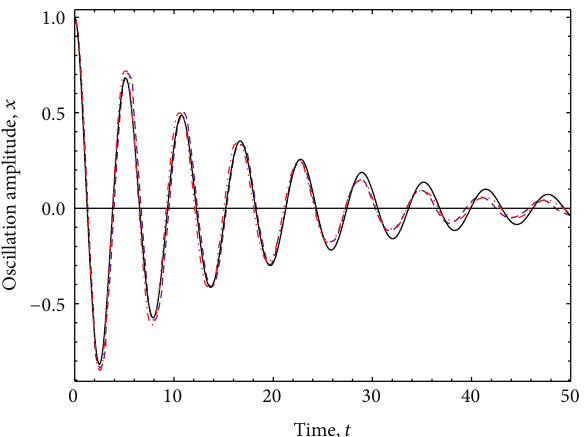
Figure 4: Amplitude-time response curves of (26), (27), and (31). Here, the solid line represents the numerical integration solution of (18), while the red and purple dashed lines represent, respectively, the numerical integration solutions of (27) and (30). The parameter values are ] = 0.1 , 𝐴 = 1 , 𝐵 = 1 , and 𝜅 = 0.1 with 𝑥 10 = 1 .